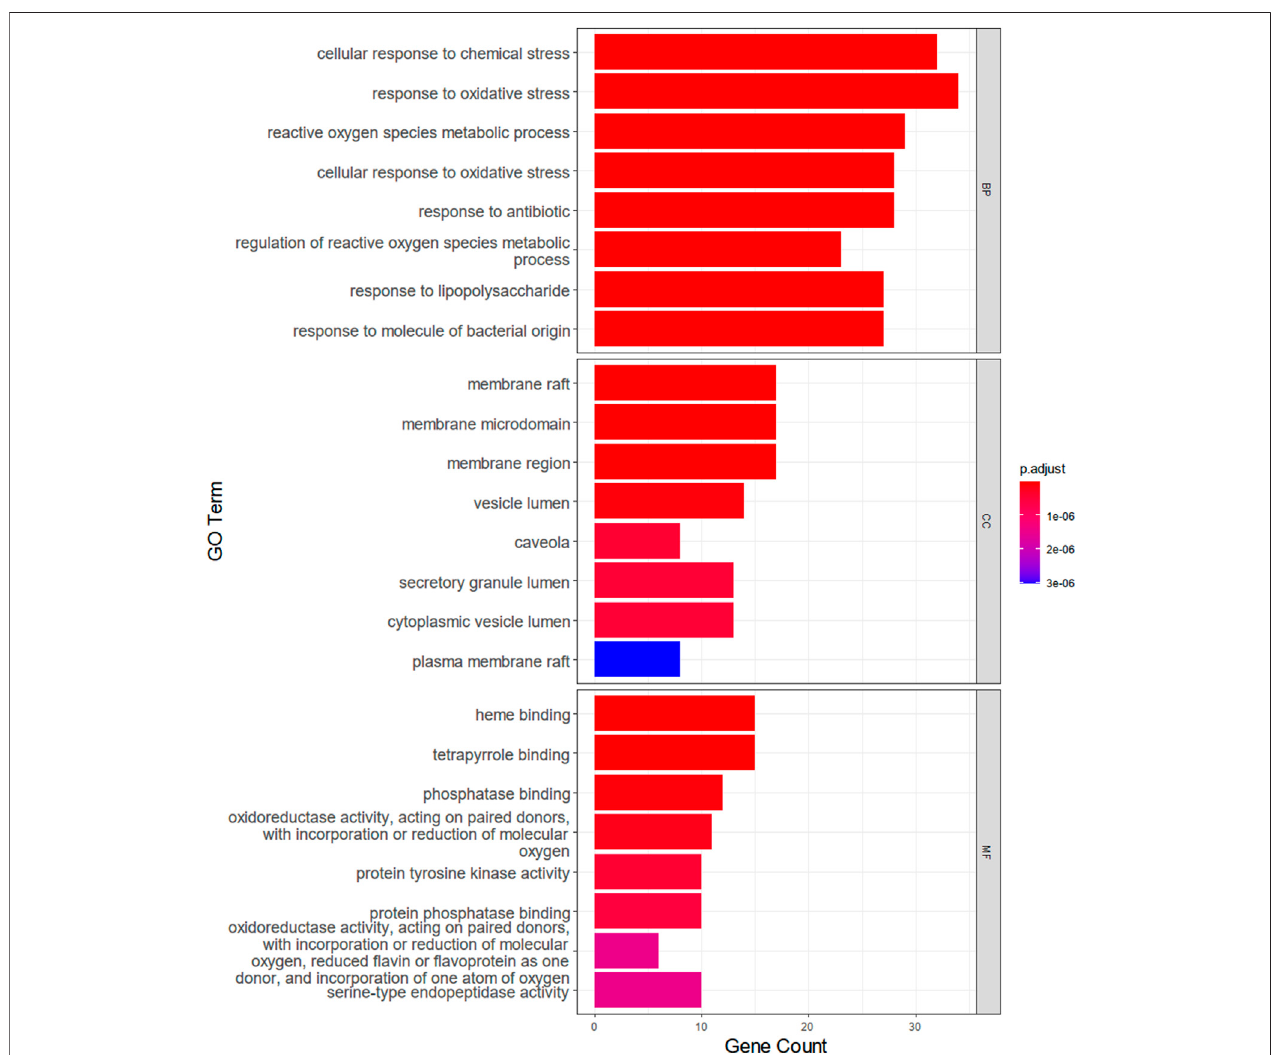
FIGURE 5 | Main Go functional annotations of the action targets of major components of H. cordata .